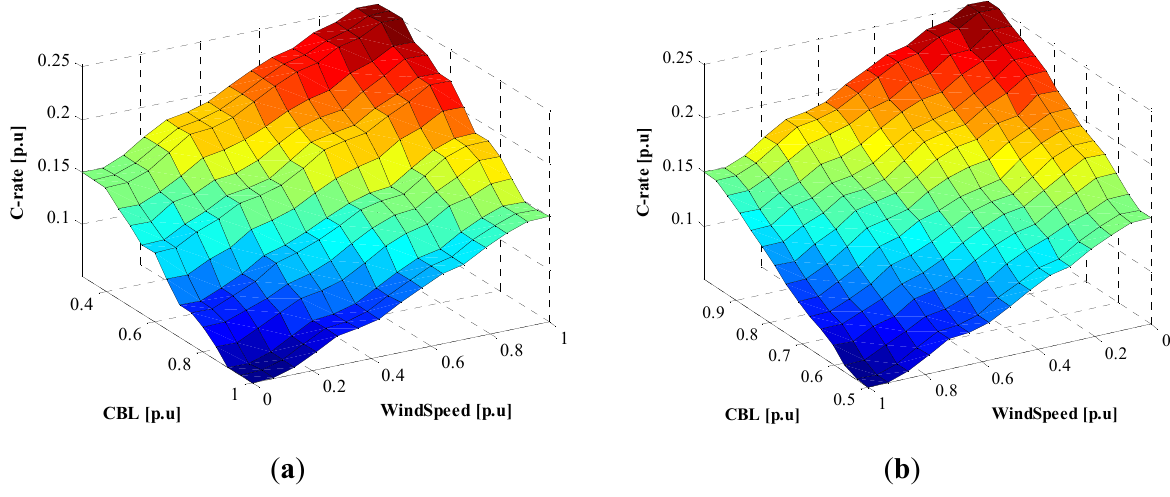
Figure 11. Three-dimensional surface map of fuzzy inference system for battery agent: ( a ) Battery charging rule in state “2”; ( b ) Batter discharging rule in state